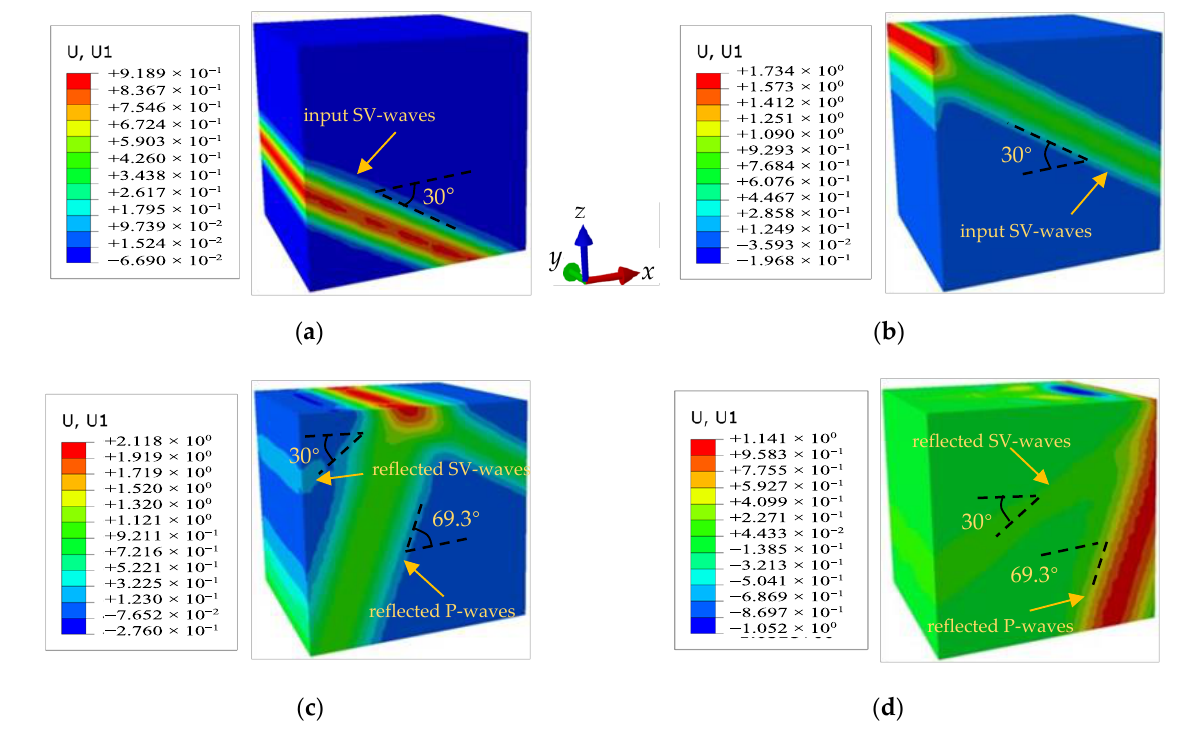
Figure 5. Displacement of half-space subjected to SV wave incidence at 30 ° (unit: m): ( a ) t = 0.46 s; ( b ) t = 0.88 s; ( c ) t = 1.13 s; ( d ) t = 1.45 s. Figure 6 is a horizontal displacement time history tie course of the center point of the